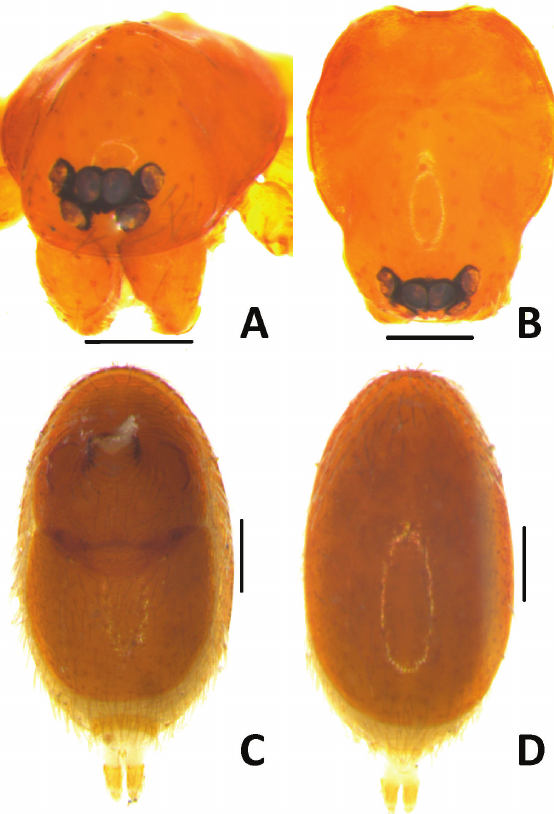
Figure 12. Pelicinus snooky n. sp., female from Ethagala FR: A , carapace, anterior view; B , same, dorsal view; C , abdo- men, ventral view; D , same, dorsal view. Scale bars: 0.2 mm ( A–D